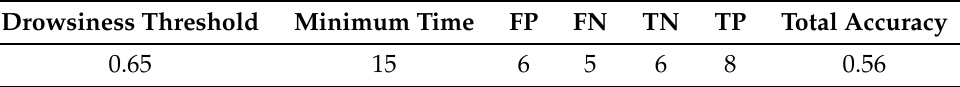
Table 4. Results obtained by Alternative I when using the system over the test data with the best combination of drowsiness _ threshold and min _ time .